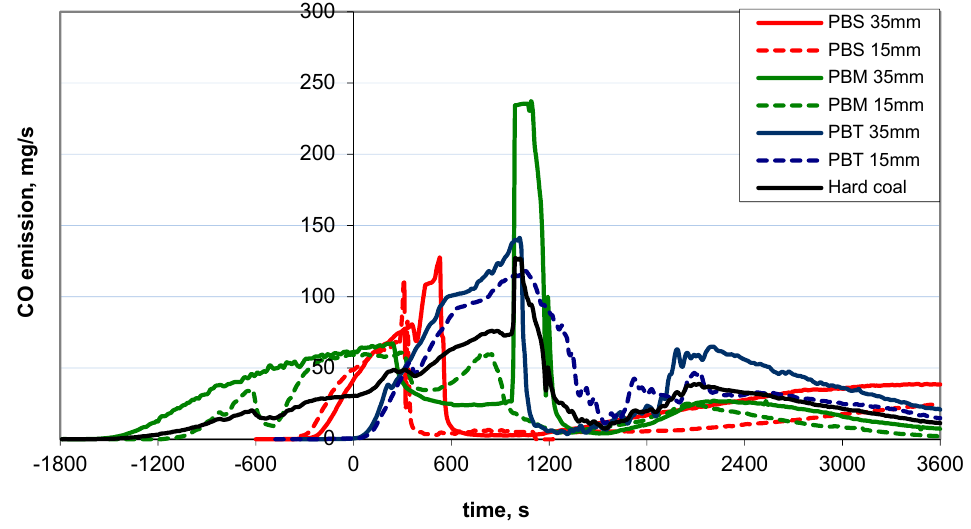
Figure 3. Variations of CO emissions during combustion of fuels.